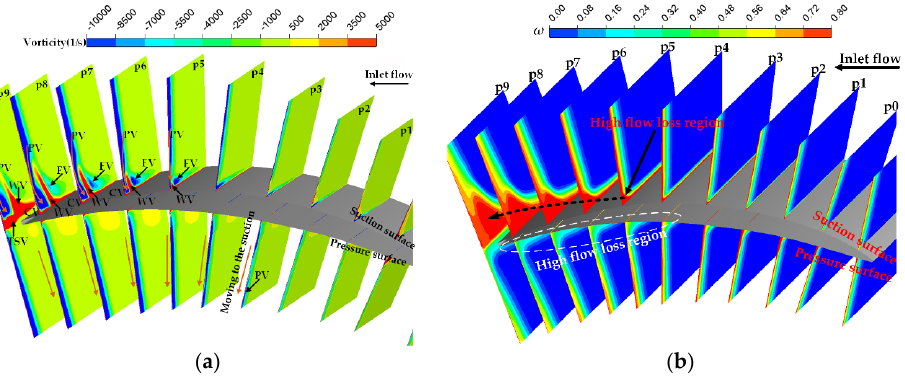
Figure 6. Flow structures within the high-speed compressor cascade corner separation and the development of the corresponding flow loss at an incidence angle of − 4°. ( a ) Flow structures. ( b ) The development of flow loss.